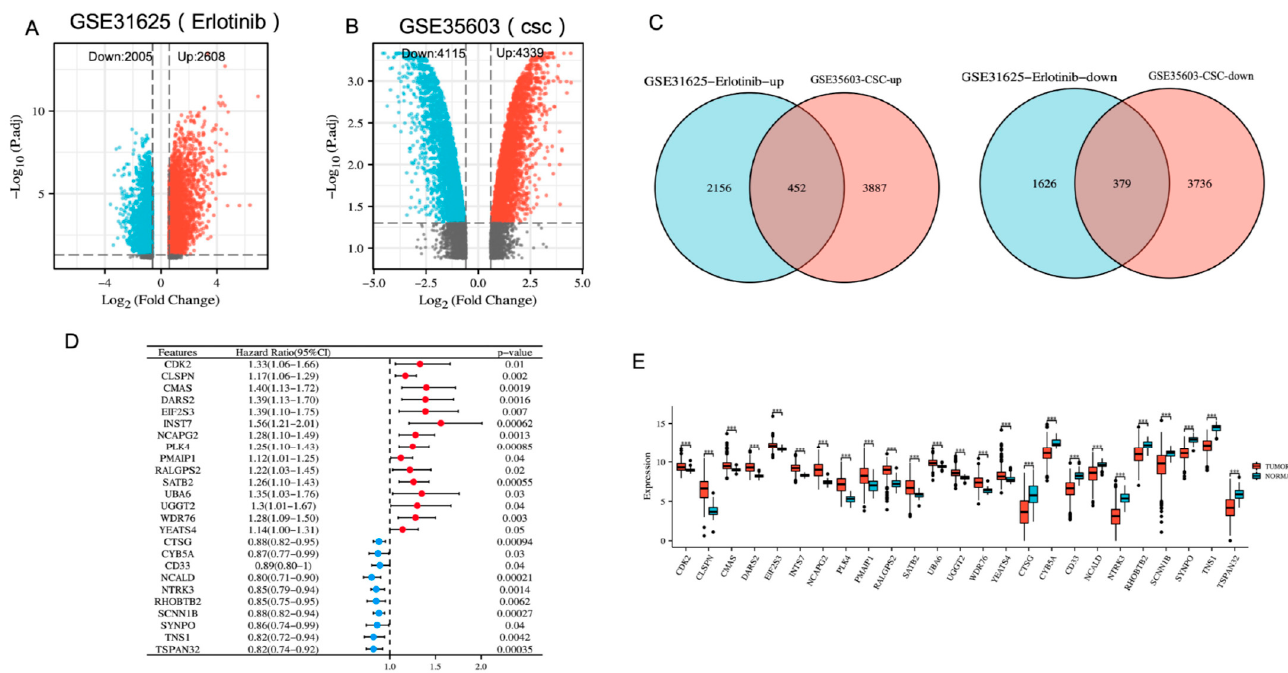
Figure 1. Identifying genes associated with erlotinib-resistance and stemness in LUAD. ( A ) DEGs associated with erlotinib-resistance (erlotinib-resistant cells versus sensitive cells) in LUAD from GSE31625. ( B ) DEGs associated with stemness (CD133 + cells versus CD133 − cells) in LUAD from GSE35603. ( C ) Venn diagram identifying genes associated with erlotinib resistance and stemness in LUAD. ( D ) Forest plot showing univariate regression analysis of intersecting genes. ( E ) Boxplots showing the expression of candidate genes. *** p < 0.001.